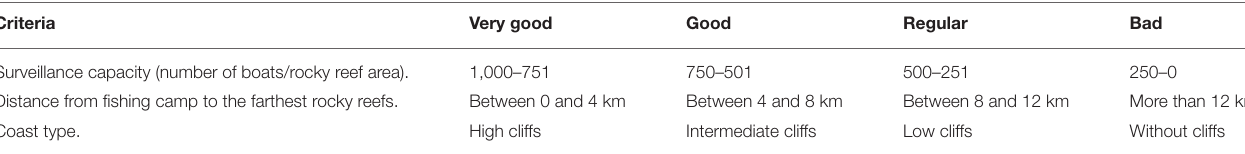
TABLE 4 | Valuation criteria developed to calculate the enforcement capacity based on the fishing polygons of red sea urchin ( Mesocentrotus franciscanus ) fishing permits or concessions. Criteria Very good Good Regular Surveillance capacity (number of boats/rocky reef